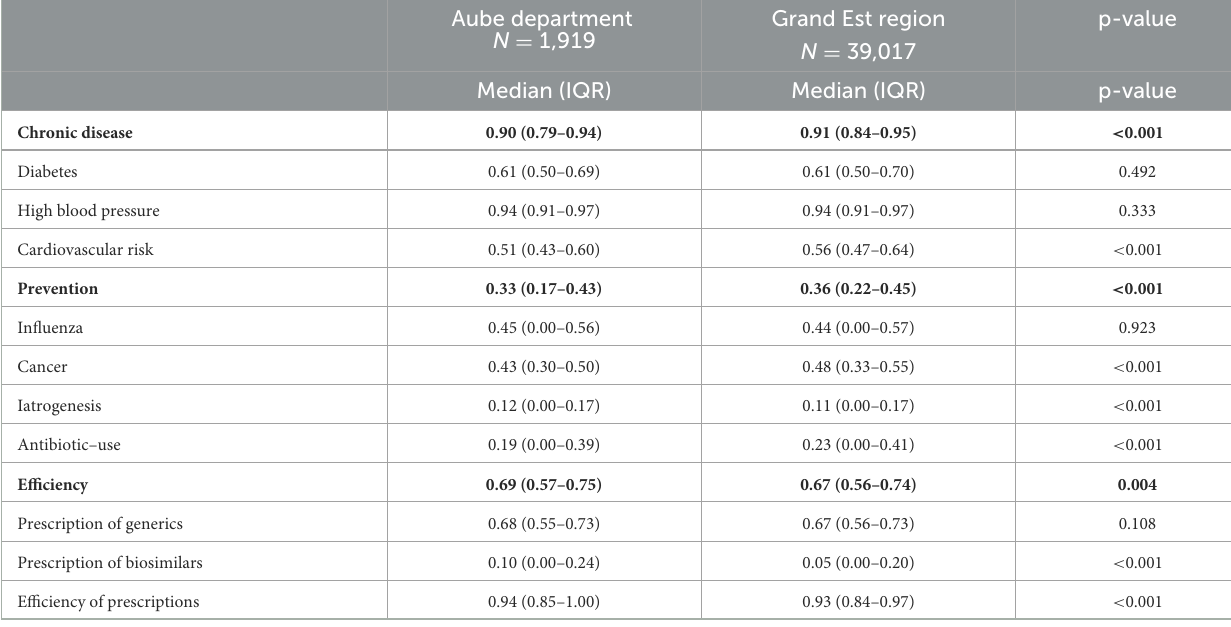
TABLE 2 Comparison of remuneration based on public health objectives (ROSP) scores in the Aube department vs. the rest of the Grand-Est Region between 2017 and 2020.